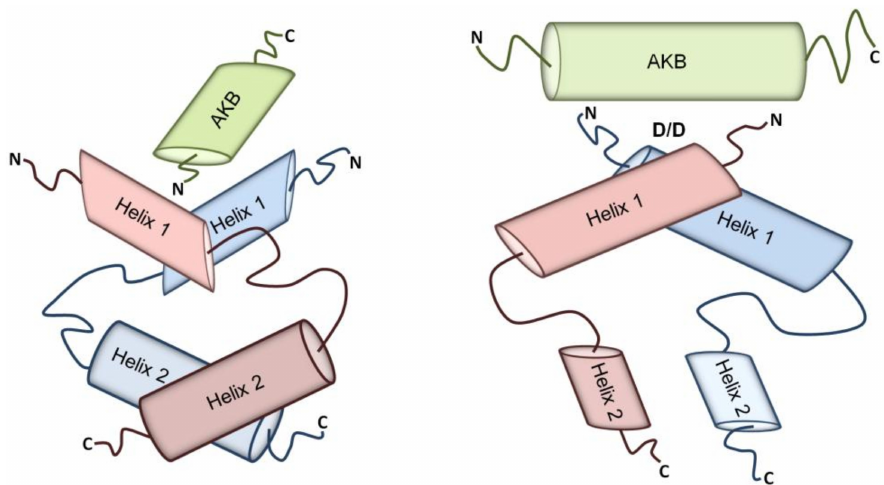
Figure 1. Schematic representation of A-kinase anchoring proteins (AKAP)-protein kinase A (PKA) interactions displayed at two different angles. The amphipathic AKB helix of AKAPs docks into the hydrophobic groove formed by the dimers of the N-terminal D/D domains of regulatory subunits of PKA. AKB A-kinase-binding domain; D / D dimerization and docking domain.